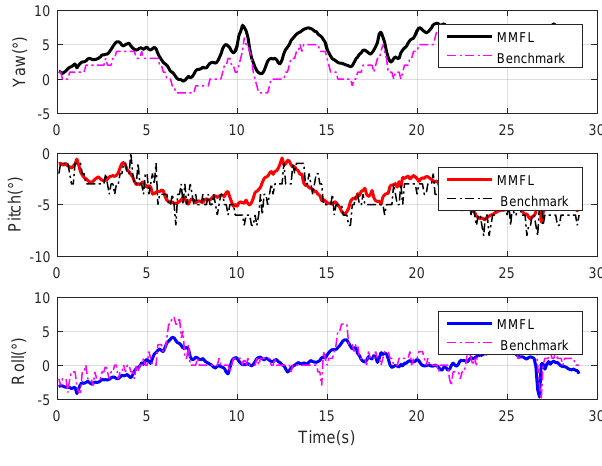
Figure 9. Attitude Estimation Result.